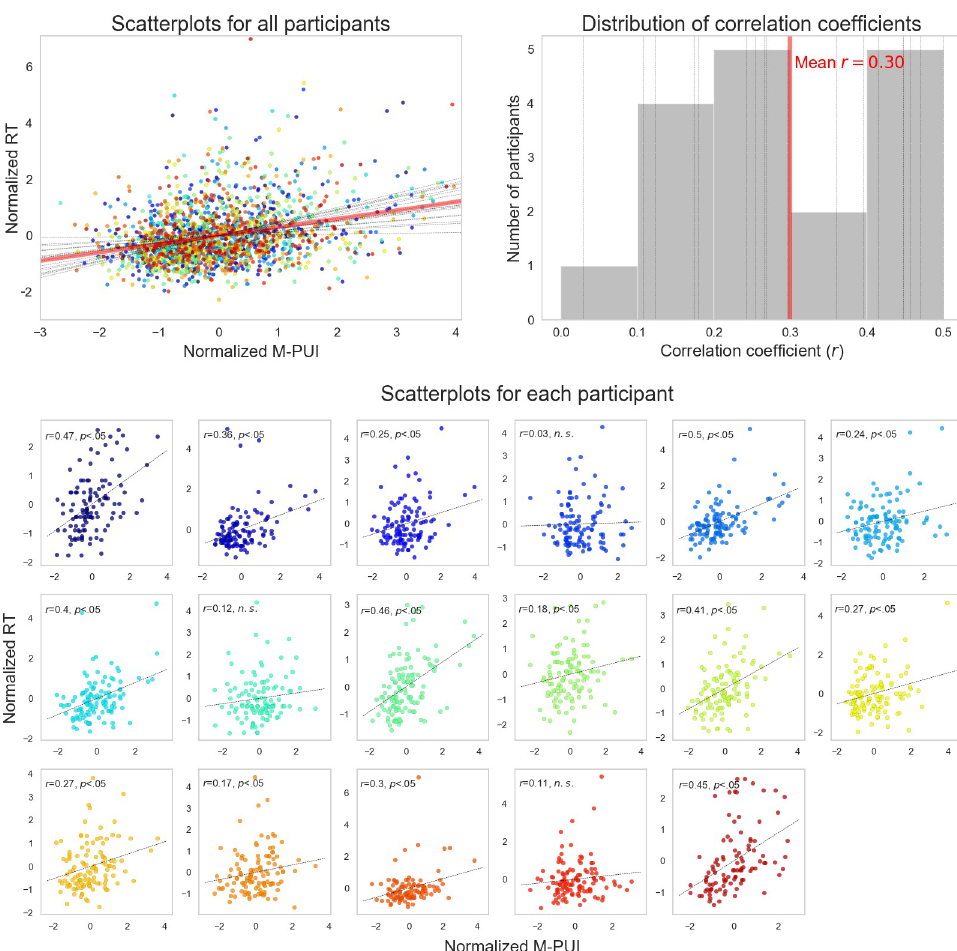
Fig 6. Scatterplot and distributions of each participants’ and correlation coefficients across all participants between normalized RT and normalized M-PUI for the 50 ms Hanning window. The top left panel represents the scatterplot between normalized RT and M-PUI for the 50 ms Hanning window for each participant and all participants. The top right panel represents the distributions of correlation coefficients between normalized RT and normalized M-PUI for the 50 ms Hanning window for each participant and all participants. The bottom panel represents all scatterplots for each participant. The different colors represent scatterplots of different individuals that are common to Fig 5. The solid red line in these panels shows the mean magnitude of the correlation coefficient for all participants, and the dotted black lines show the magnitudes of the correlation coefficient for each participant.